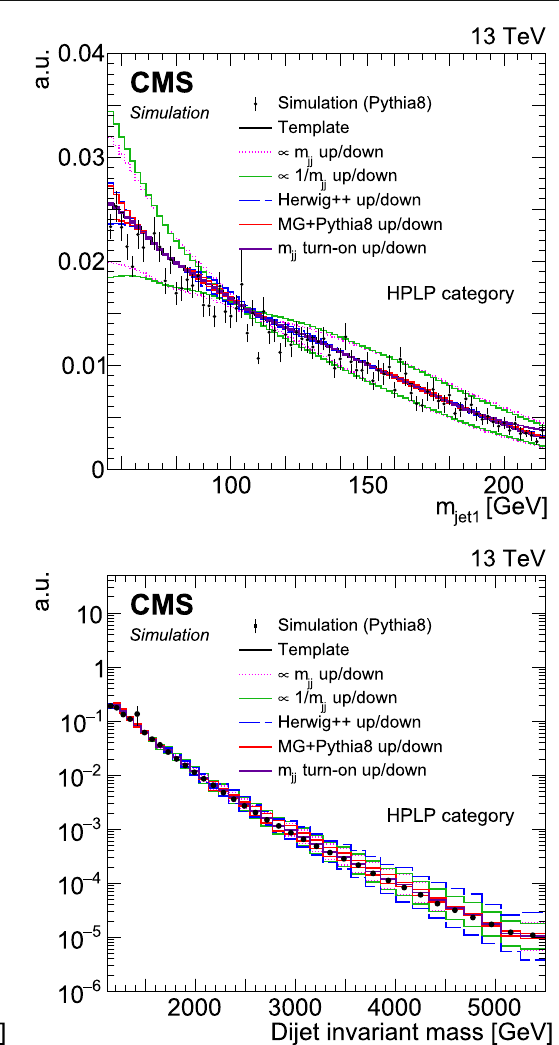
Fig. 9 Nominal QCD multijet simulation using pythia 8 (data points) and three-dimensional pdfs derived using a forward-folding kernel approach(blacksolidline),showntogetherwiththefivealternateshapes thatareaddedtothemulti-dimensionalfitasshapenuisanceparameters. The shapes for the high-purity (left) and low-purity (right) categories obtained with the 2017 simulation are shown for the projection on m jet1